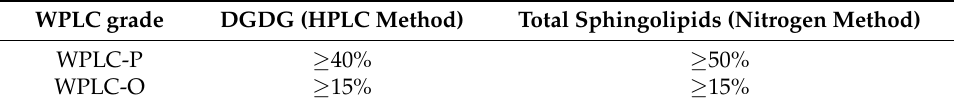
Table 3. WPLC active ingredients